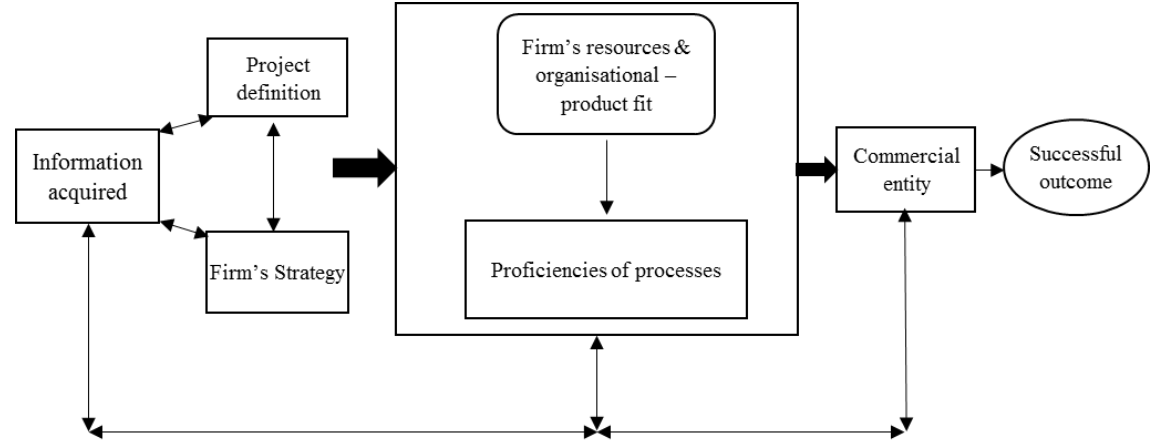
Fig. 1 The proposed Conceptual model